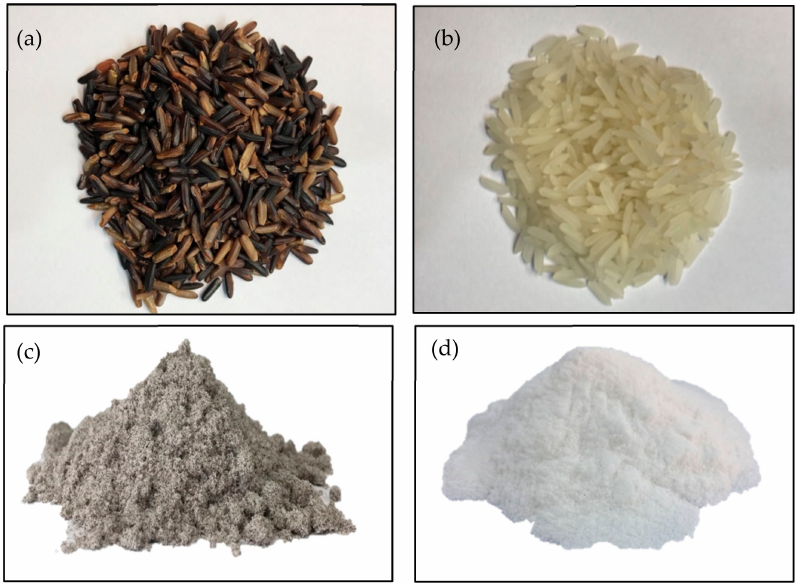
Figure 1. The appearance of Hom Nil rice (HN) ( a ) and Hom Mali 105 rice (HM) ( b ), HN flour ( c ) and HM flour ( d